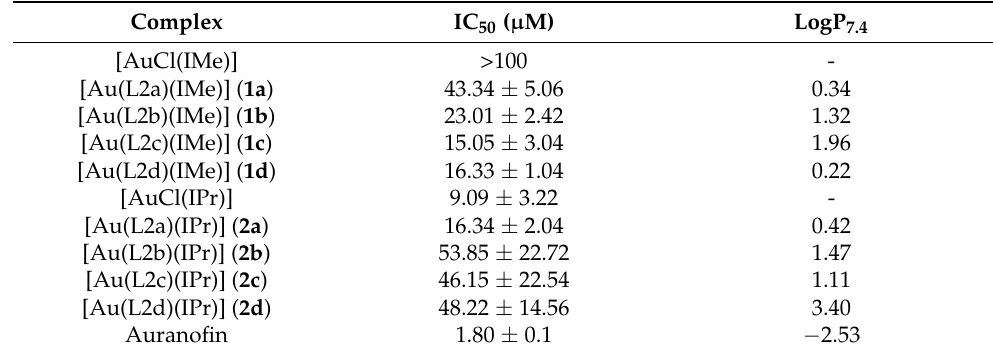
Table 2. IC 50 values ( µ M) and distribution coefficients of carbene gold(I) complexes derived from 3-hydroxyflavones on Caco-2 cell line upon 72 h incubation. IC 50 values of starting material as well as auranofin are included. Results are expressed as mean ± SE of at least three determinations.